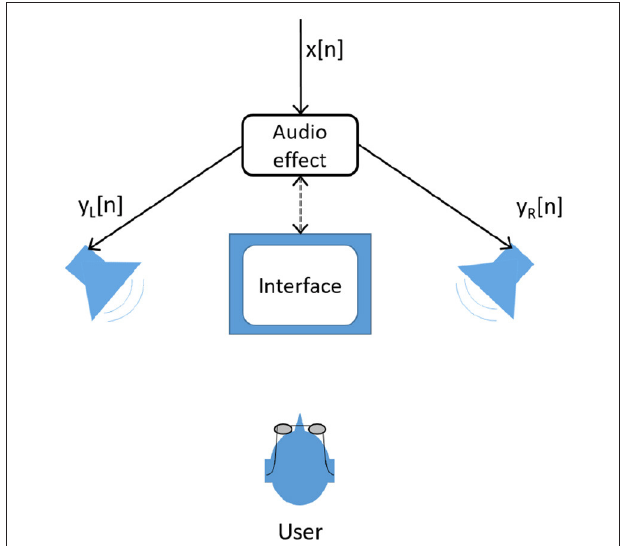
FIGURE 2 | Interaction with a non-adaptive audio effect where the user interacts with an interface to control its